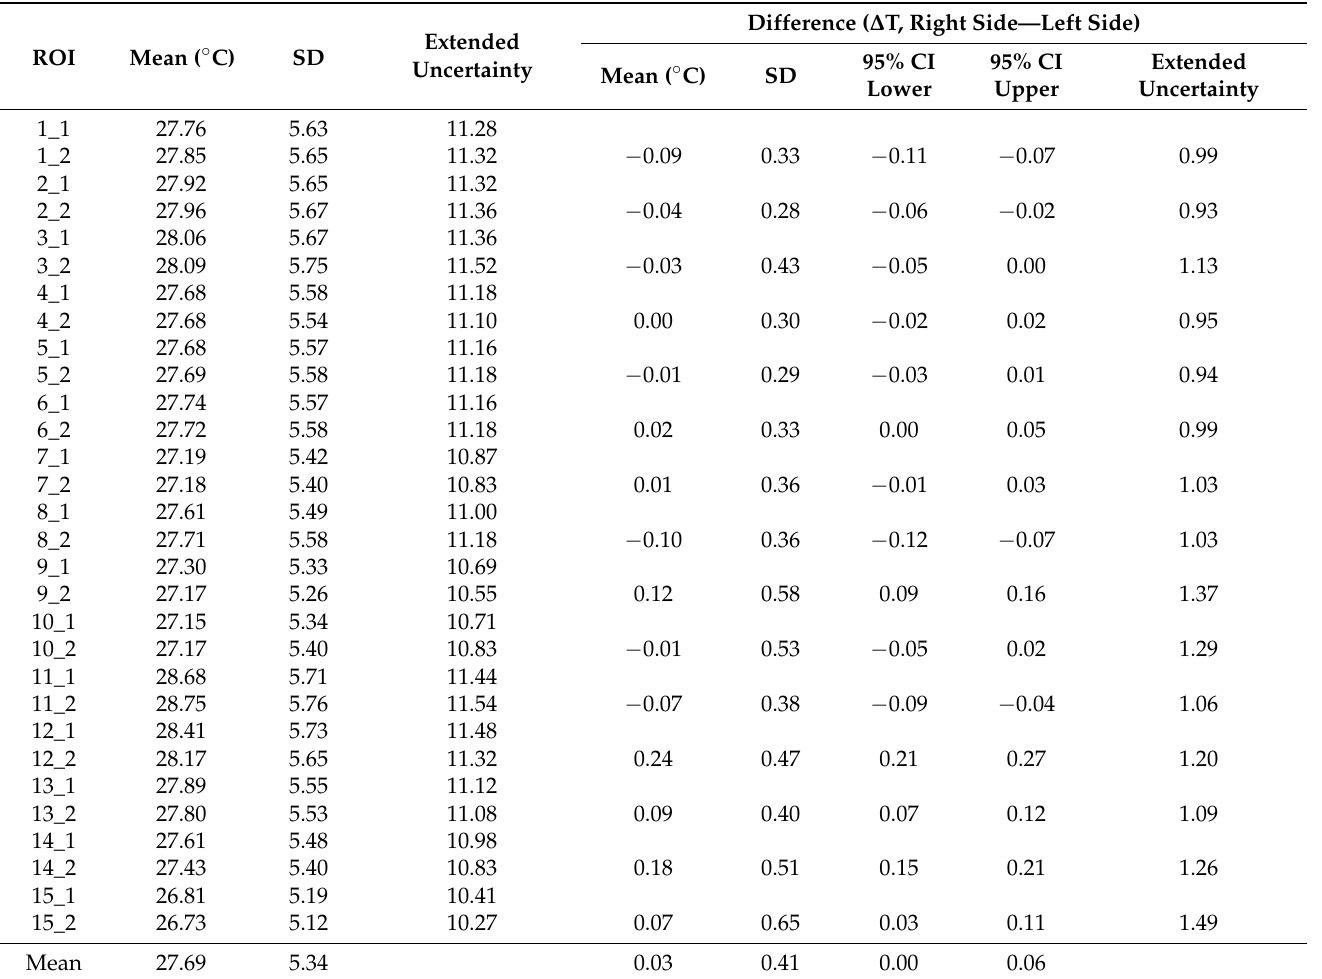
Table 1. Overall mean temperature of regions of interest in the front